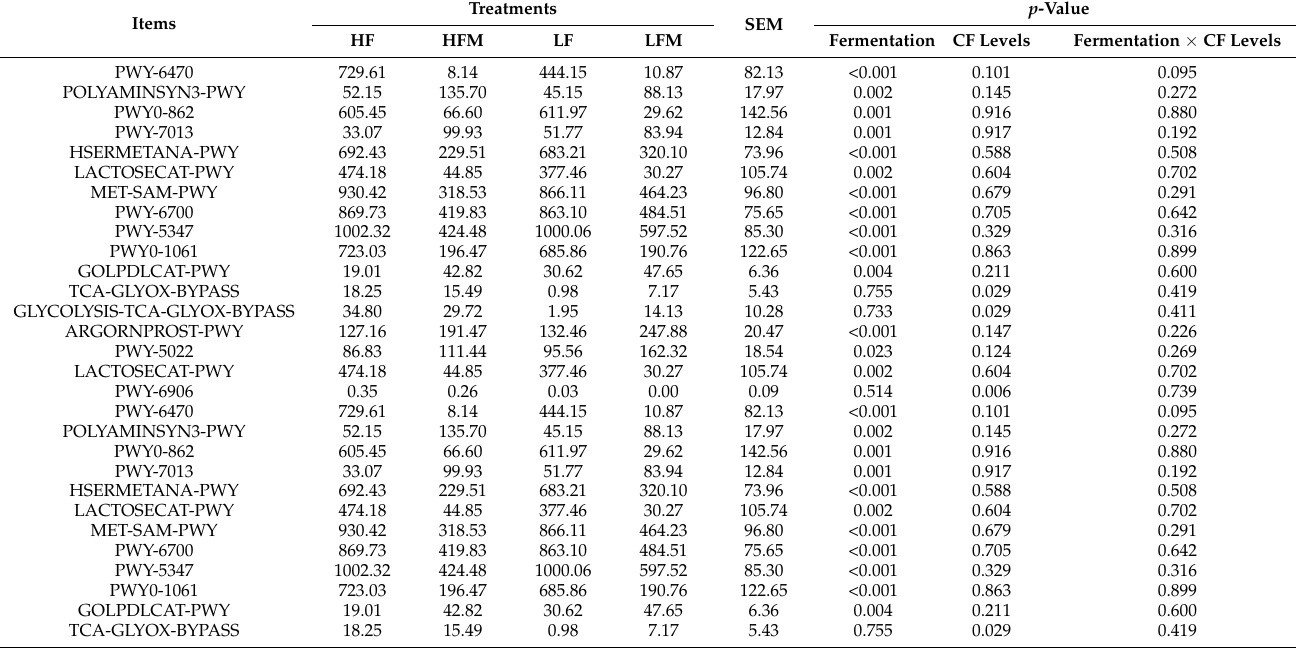
Table 7. Effects of multi-bacteria fermentation and dietary CF level on the relative abundances of the associated nutrients’ metabolic pathways of rectal